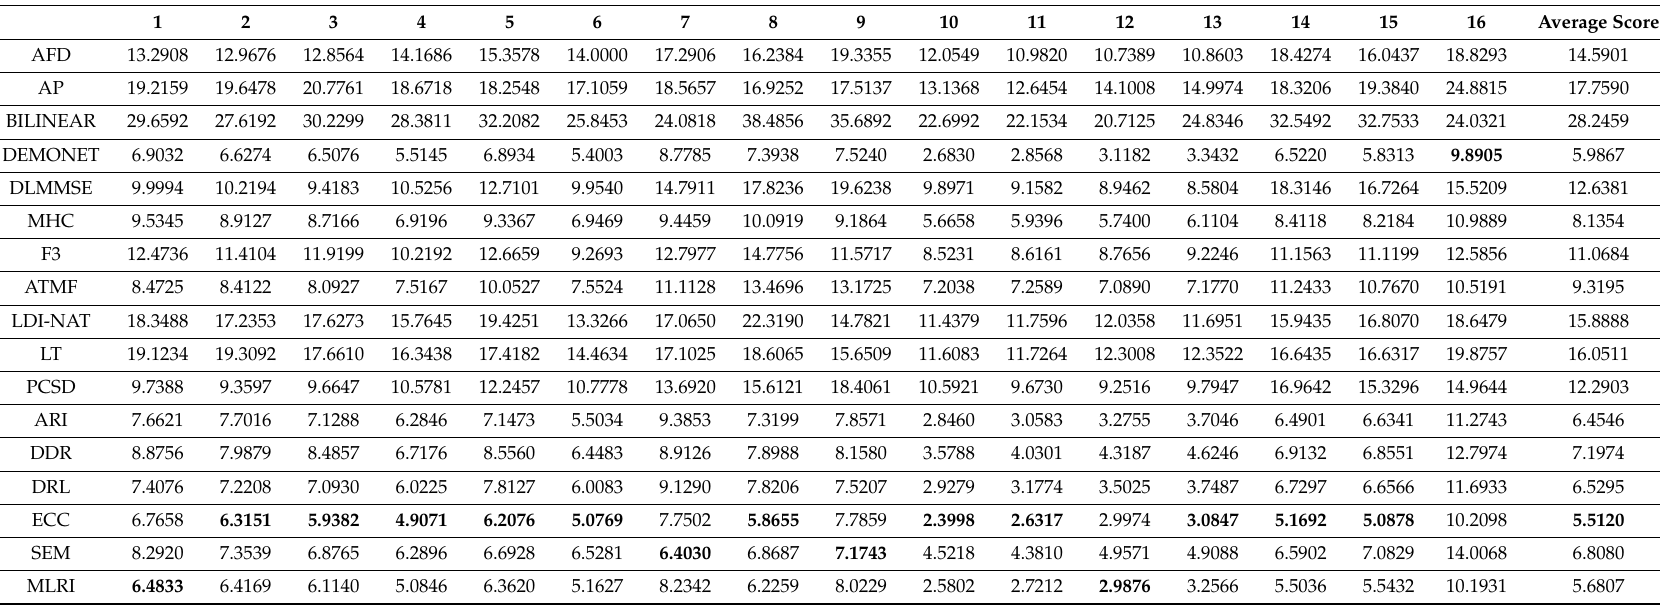
Table 4. Summary of NIQE scores (lower means better). Sixteen left images: Averaged over R, G, and B